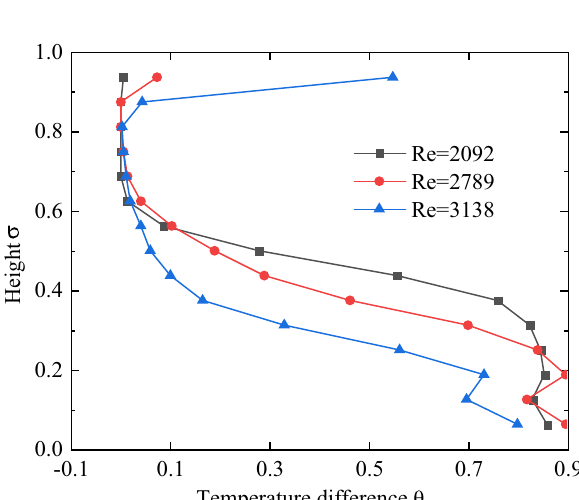
Fig. 21 Temperature change of L1 when Fo is 0.9 with inner tube diameter of 17